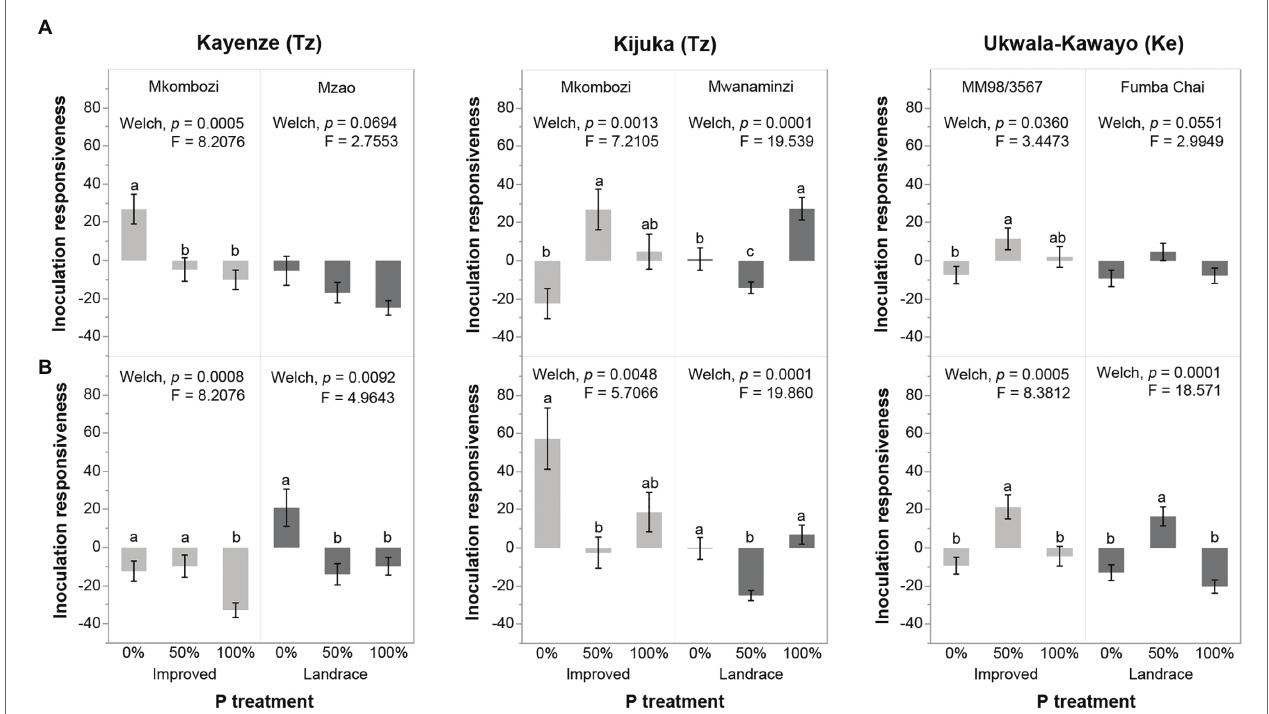
FIGURE 3 | Inoculation responsiveness of cassava to AMF inoculation at the three different P fertilization levels, in two cassava varieties at each of three locations. Inoculation responsiveness was calculated based on cassava root fresh weight response to AMF inoculation compared to (A) the non-inoculated treatment and (B) the carrier without fungus treatment. Error bars represent ±SE. Means with different letters are significantly different at p < 0.05 according to a Games-Howell post hoc test. Post hoc comparisons were among P treatments within each cassava variety at each location separately. Tz, Tanzania; Ke,